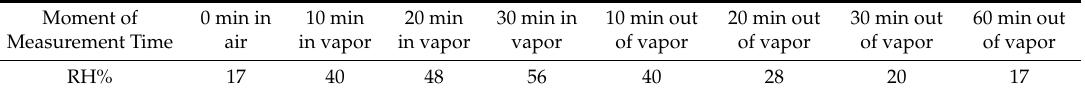
Table 1. Time dependence of the humidity (RH%) obtained in